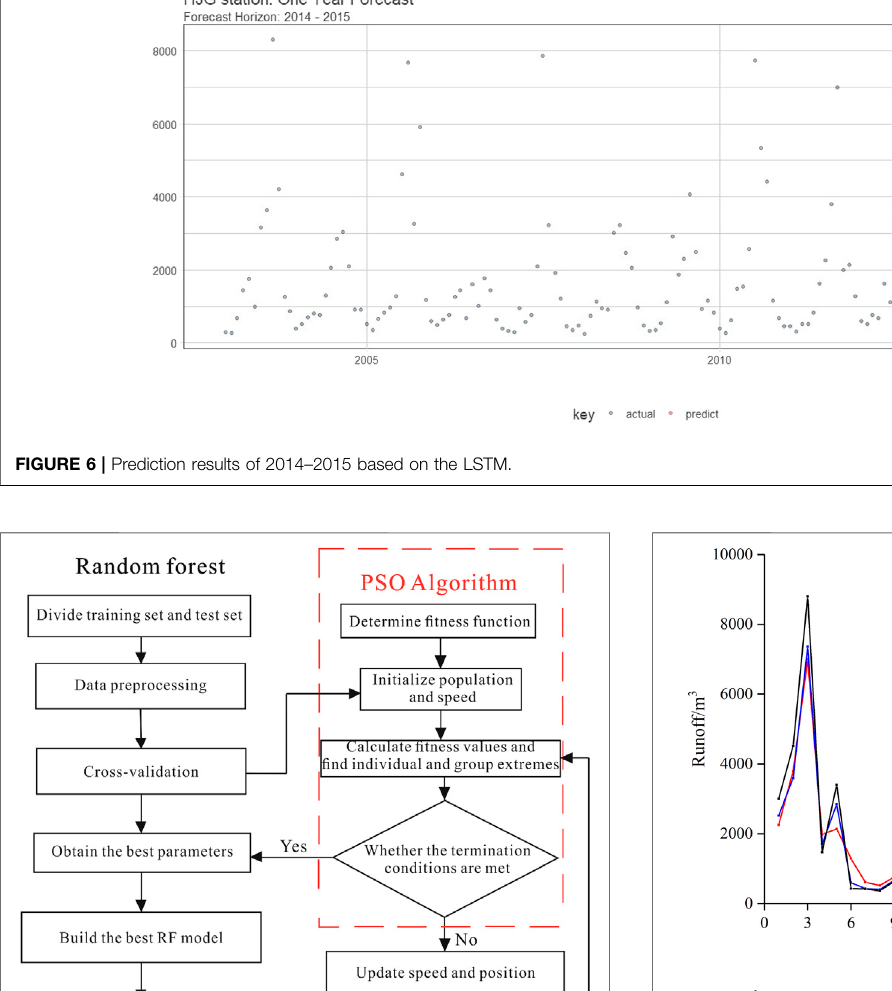
FIGURE 8 | Prediction results based on different